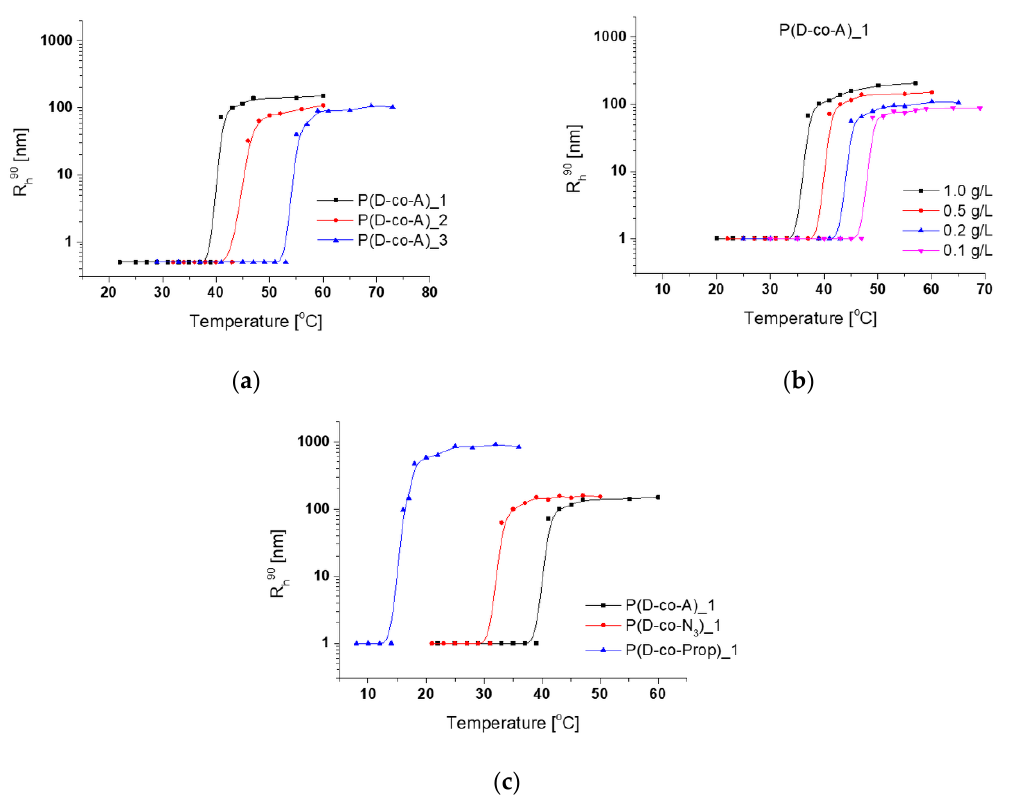
Figure 4. Apparent hydrodynamic radius ( 𝑅 ℎ 90 ) of particles versus temperature for ( a ) P(D-co-A)s at a concentration of 0.5 g/L; ( b ) P(D-co-A)_1 at different solution concentrations; ( c ) P(D-co-A)_1, P(D-co-N3)_1, and P(D-co-Prop)_1 at a concentration of 0.5 g/L. Table 3. Average apparent hydrodynamic radii 𝑅 ℎ90 of mesoglobules formed by copolymers at 0.5 g/L above the T CP (obtained by gradual heating) Amount of A in Initial Amount of A in initial P(D-co- A) Per chain